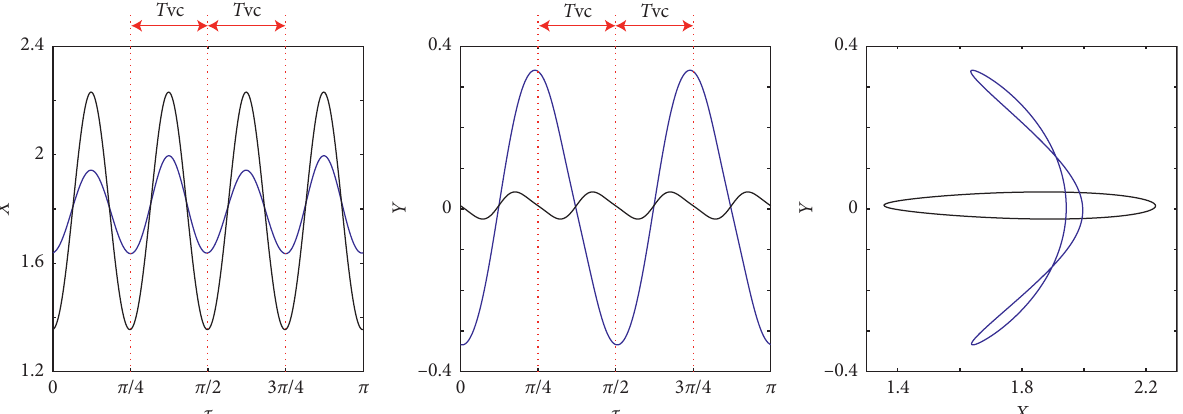
Figure 5: Time series and phase orbits of coexisting period-1 (black line) and period-2 (blue line) motions for δ when Ω � 230rad/s.